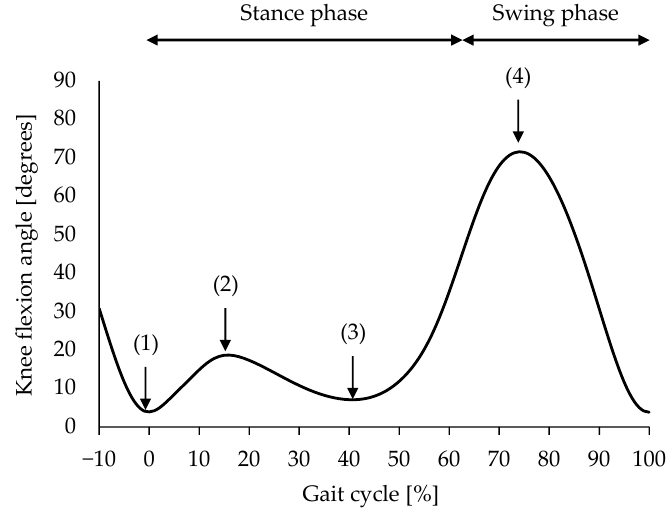
Figure 4. Gait cycle and discrete values of interest for analysis. The gait cycle was normalised as the period from peak knee extension during the swing phase (1) to that during the next swing phase (0–100%). For discrete value analysis, the peak knee extension angle during the swing phase (1), peak knee flexion during the first half of the stance phase (2), peak knee extension during the second half of the stance phase (3), and peak knee flexion during the swing phase (4) were